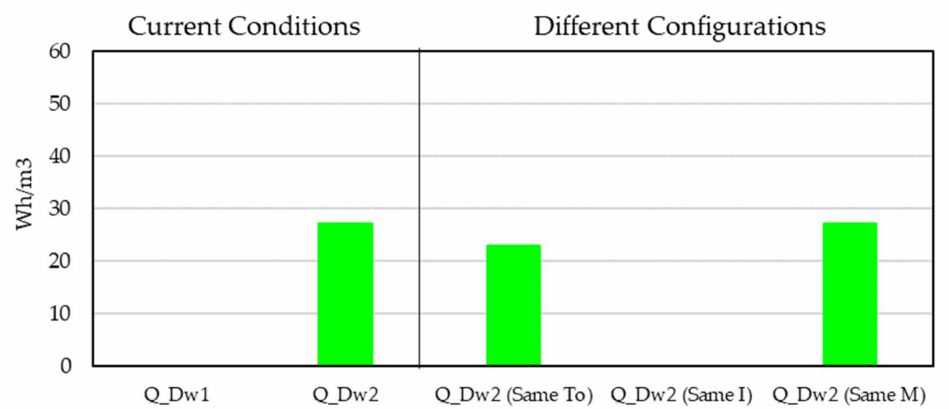
Figure 12. The calculated heating demand of Dw1 (magenta) and Dw2 (green) according to the current energy use (Q_Dw1 and Q_Dw2), and Dw2’s heating demand calculated with Dw1’s outdoor temperature (Q_(Same To)), with Dw1’s solar gains by windows (Q_Dw2 (same I)), and with Dw1’s building volumetric heat capacity (Q_Dw2 (same